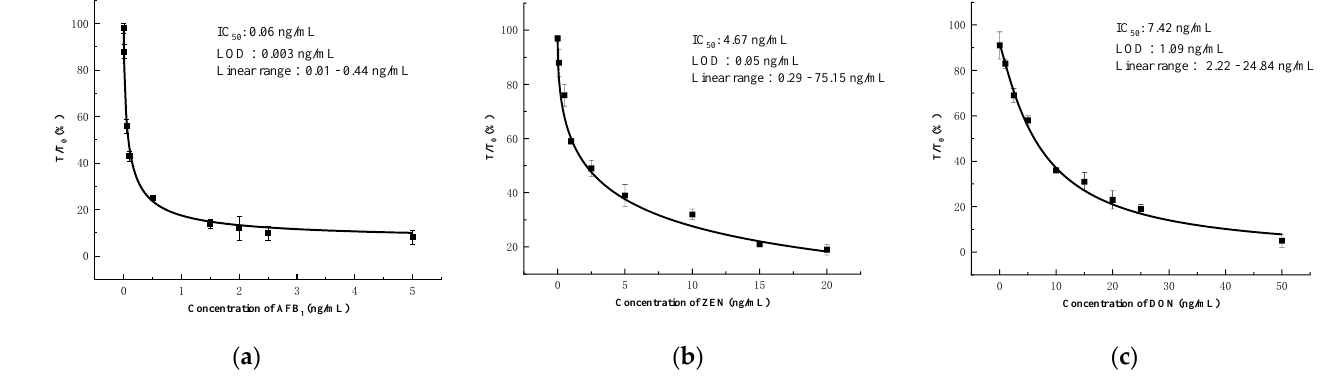
Figure 8. The calibration curve of mMicrofluidics: ( a ) AFB 1 ; ( b ) ZEN; ( c ) DON.